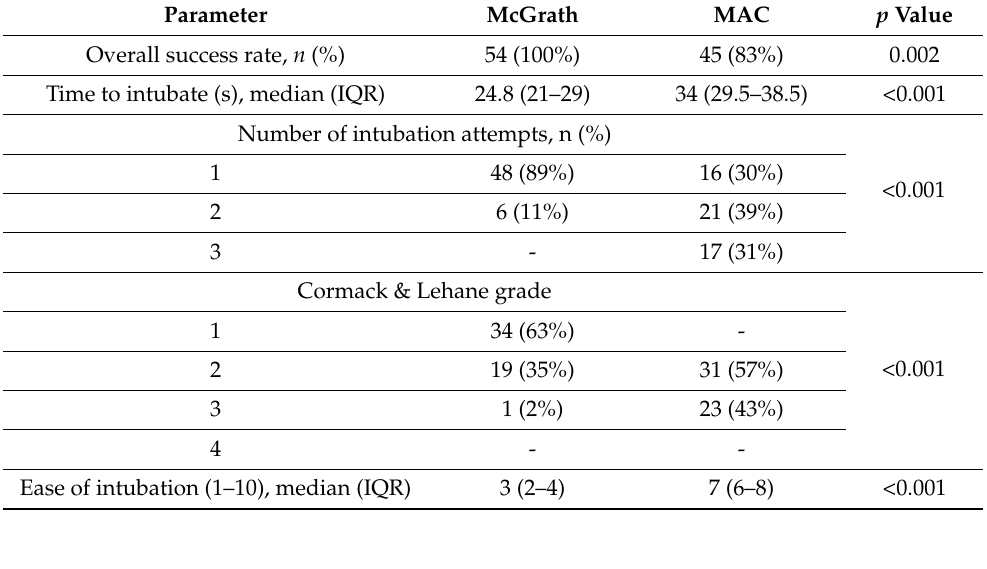
Table 2. Intubation with McGrath and Macintosh laryngoscopes with PPE-AGP scenario. Parameter McGrath